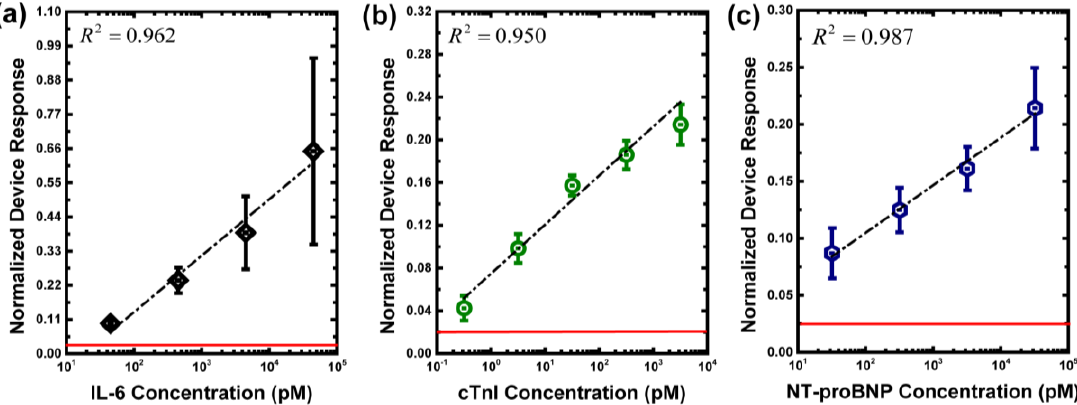
Figure 3. Experimental results of three biomarkers in PBS buffers. ( a ) IL-6; ( b ) cTnI; ( c ) NT-proBNP. The red line marks the noise level.